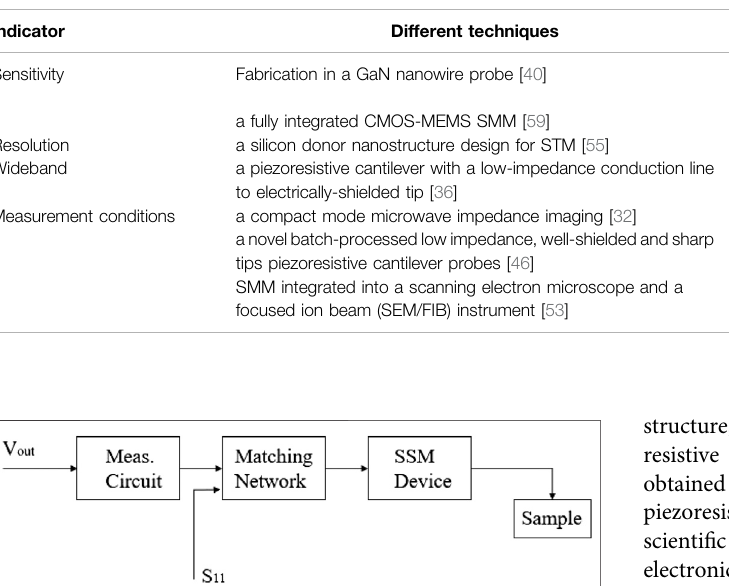
TABLE 1 | Summarization of different techniques for the improvement of MIM.